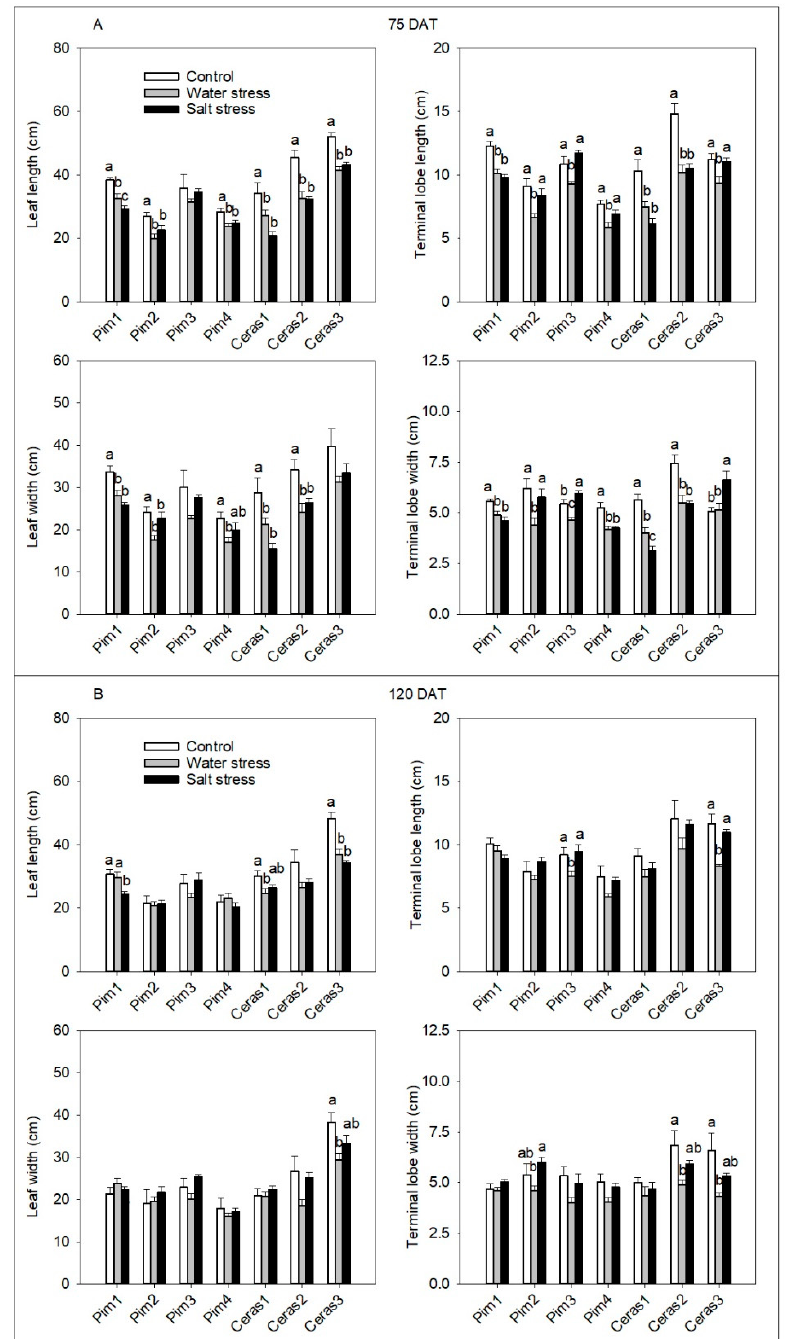
Figure 5 . Leaf and terminal lobe length and width (cm) in accessions Pim1, Pim2, Pim3, Pim4, Ceras1, Ceras2, and Ceras3 under control, water stress and salt treatment after 75 ( A ) and 120 ( B ) days of treatment (DAT). Data are mean values ± SE for n = 8 plants. Within each accession, different letters indicate significant differences at p < 0.05 (LSD test). Analysis of two-way ANOVA is provided in supplementary material in Table S4. SE: Standard error.